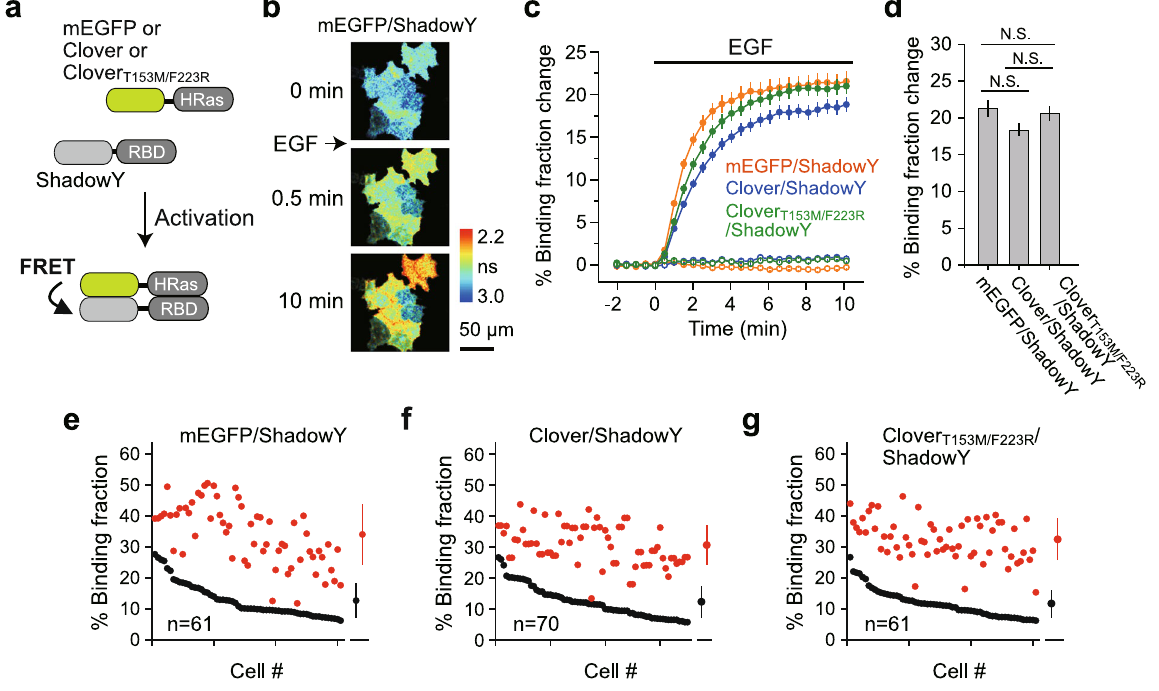
Figure 6. The performance of ShadowY in H-Ras FRET sensors in HeLa cells. ( a ) A schematic of the H-Ras FRET sensor activation. ( b ) Representative fluorescence lifetime images of mEGFP-H-Ras paired with ShadowY fused to the Ras-binding domain (RBD) in HeLa cells after stimulation with 50 nM EGF. The scale bar is 50 µ m. ( c ) An averaged time course of binding fraction changes in response to EGF stimulation (filled circles) or with empty buffer (open circles; control). Cells showing a 5–30% basal binding fraction (before stimulation) were chosen for the analysis. The number of cells analyzed is 61 for mEGFP–ShadowY, 70 for Clover–ShadowY, and 61 for Clover T153M/F223R –ShadowY. In the control, the number of cells analyzed is 45 for mEGFP–ShadowY, 18 for Clover–ShadowY, and 31 for Clover T153M/F223R –ShadowY. The data are presented as mean ± SEM. ( d ) Binding fraction changes (averaged over 8 to 10 min) after EGF stimulation. The data are presented as mean ± SEM; N. S. = not statistically significant (p > 0.05, analysis of variance [ANOVA] followed by Scheffé’s post hoc test). ( e – g ) Activation of H-Ras in individual HeLa cells after stimulation with EGF (the same dataset as in panel c). The basal binding fraction (averaged over − 2 to 0 min) of individual cells is plotted in the descending order (black) along with the corresponding binding fraction (averaged over 8 to 10 min) after EGF stimulation (red). The data are also presented as mean ± SD on the